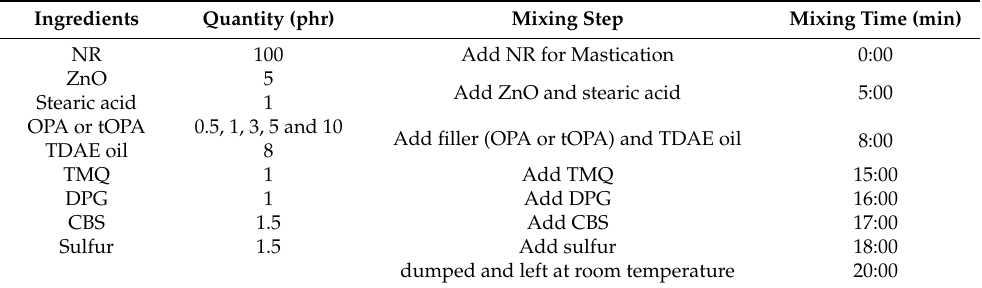
Table 2. The compound formulation and mixing schedule of unfilled and filled NR with untreated OPA (OPA) and 3M NaOH-treated OPA (tOPA) at different loading.